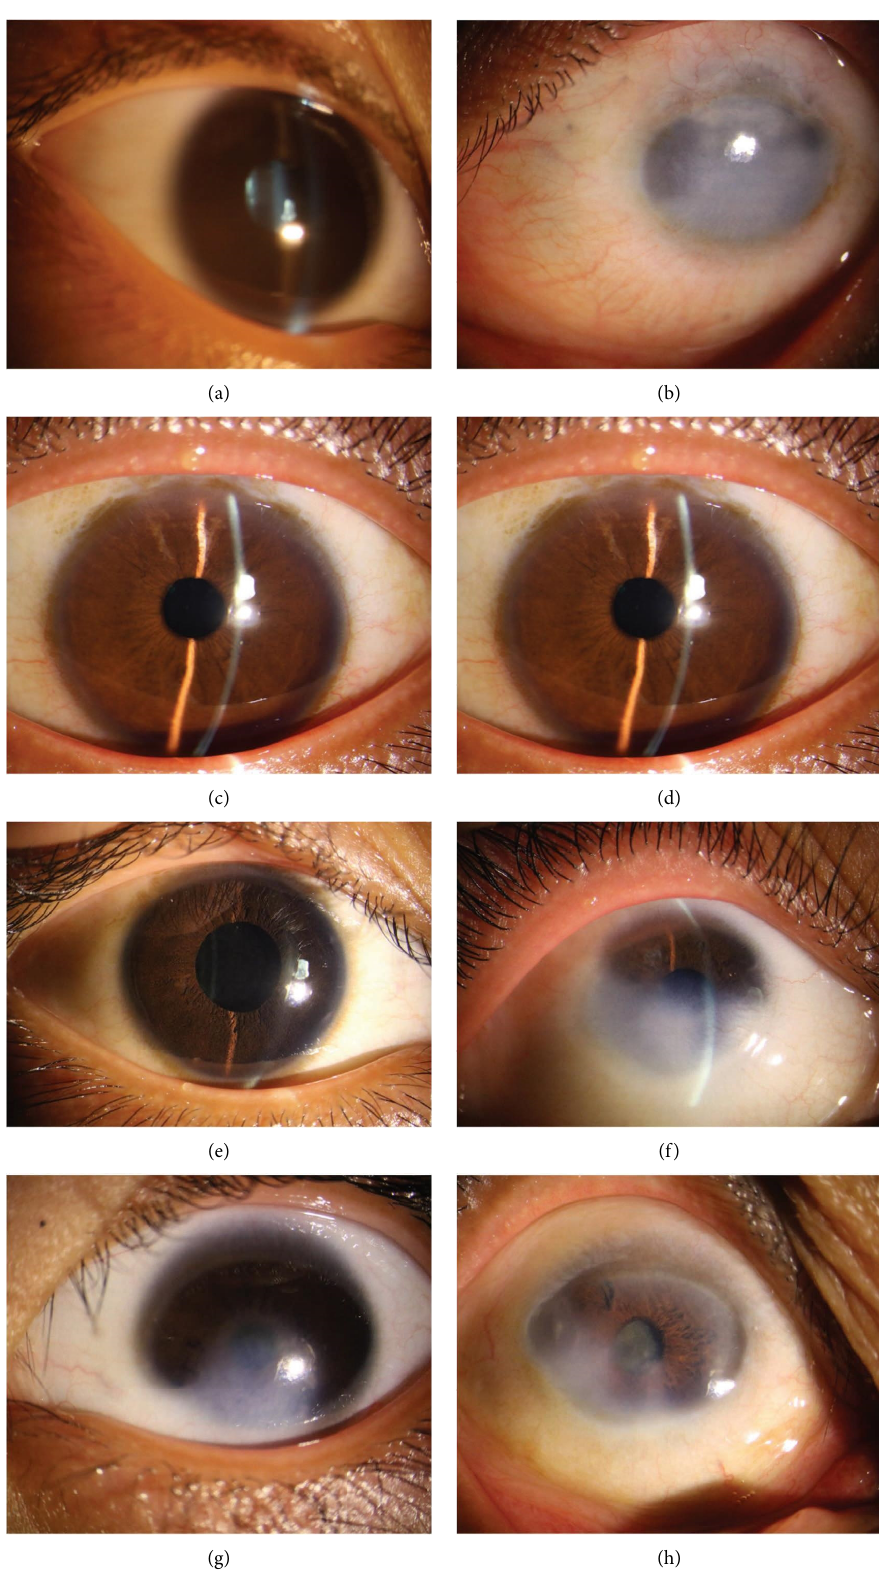
Figure 2: Slit lamp examination of the patients. (a) Patient IV: 4: subcapsular punctate opacities at the posterior pole of the lens; (b) patient II: 3: corneal leukoplakia, about 8 mm in diameter, the inner eye structure is not visible; (c) patient III: 4: left eye received cataract surgery, upper iris injury and partial depigementation can be observed; (d) patient III: 6: left eye received cataract surgery, the position of intraocular lens was normal; (e) patient IV: 2: right eye received cataract surgery, the position of intraocular lens was normal; (f) patient III: 3: congenital leukoplakia+congenital small cornea, no surgery; (g) patient IV: 3: congenital leukoplakia +congenital small cornea, no surgery; and (h) patient II: 7: congenital corneal leukoplakia+congenital small cornea+ congenital